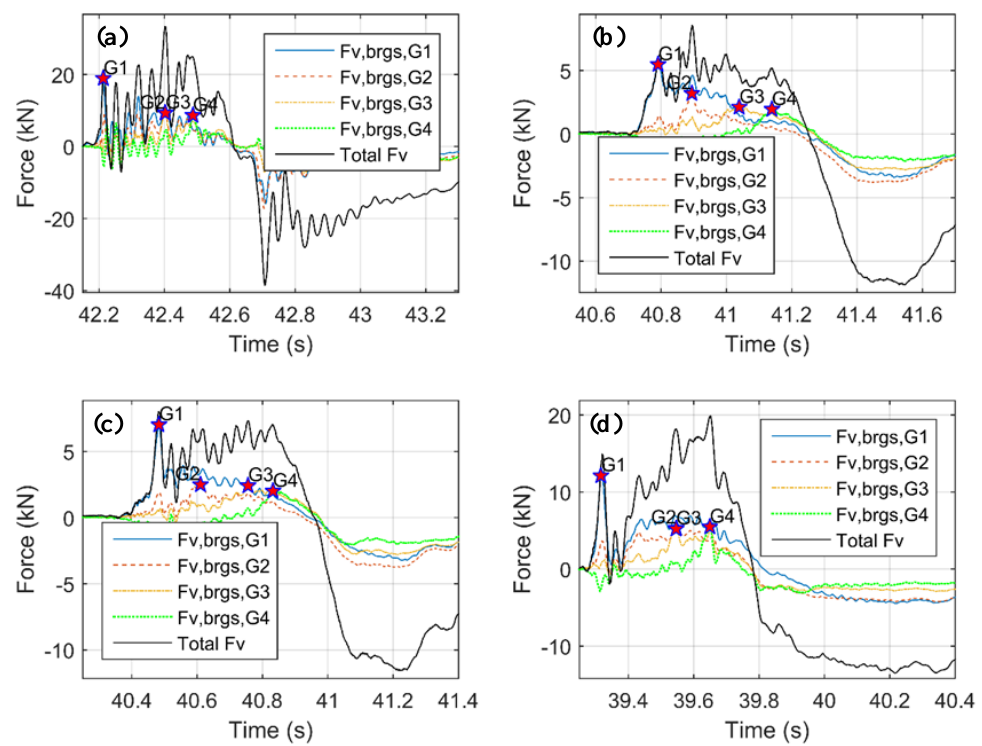
Figure 7. Vertical force histories in the steel bearings for solitary waves with H = 0.70 m ( a) , and bores with H = 1.0 m ( b ), H = 1.10 m ( c ) and H = 1.40 m ( d ).